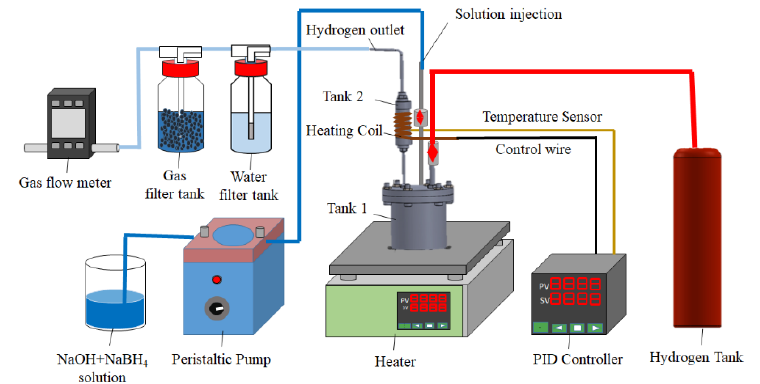
Figure 14. Schematic diagram of the experimental setup.